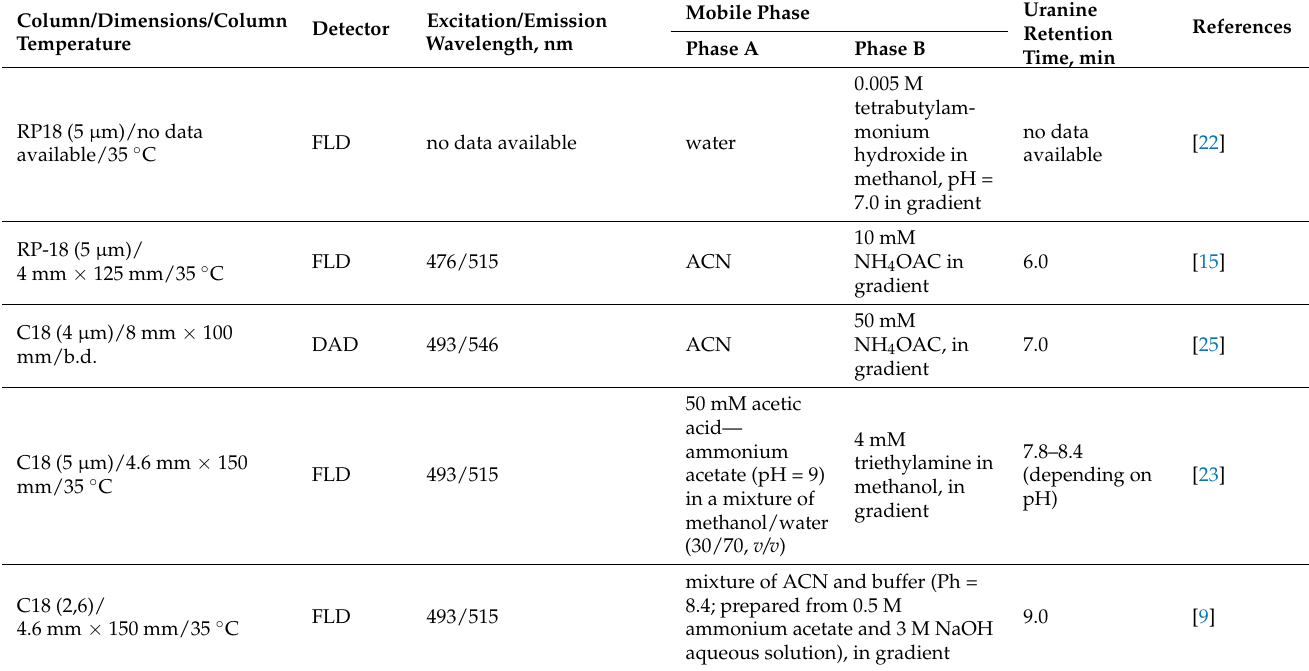
Table 1. Summary of data available in the literature on HPLC systems used for uranine separation in water samples. Column/Dimensions/Column